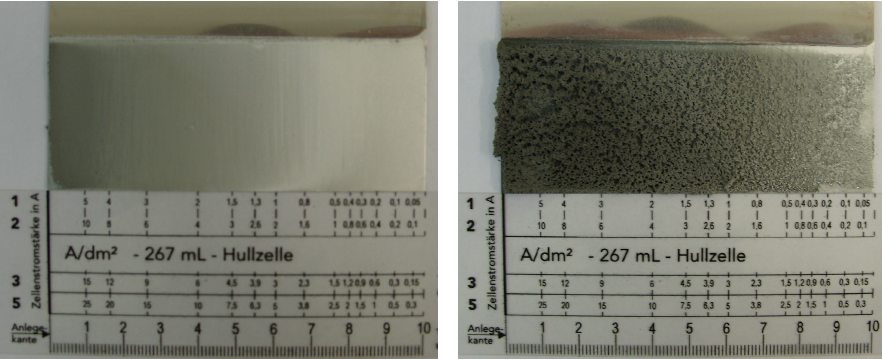
Figure 4 – Illustration of the Sn-Zn layer surface obtained from an electrolyte with 0.05 mol/l Zn; 0.05 mol/l Sn and 0.25 mol/l K4P2O7 at pH = 9.3 with 1 g/l gelatine (left) and in the absence of gelatine (right) (Working parameters: 1A; 60°C; 20 min.) Рис . 4 – Поверхностный слой покрытия Sn-Zn, полученный из электролита при 0.05 mol/l Zn; 0.05 mol/l Sn и 0.25 mol/l K4P2O7 при значении pH = 9.3 с применением 1 g/l желатина ( слева ) и без применения желатина ( справа